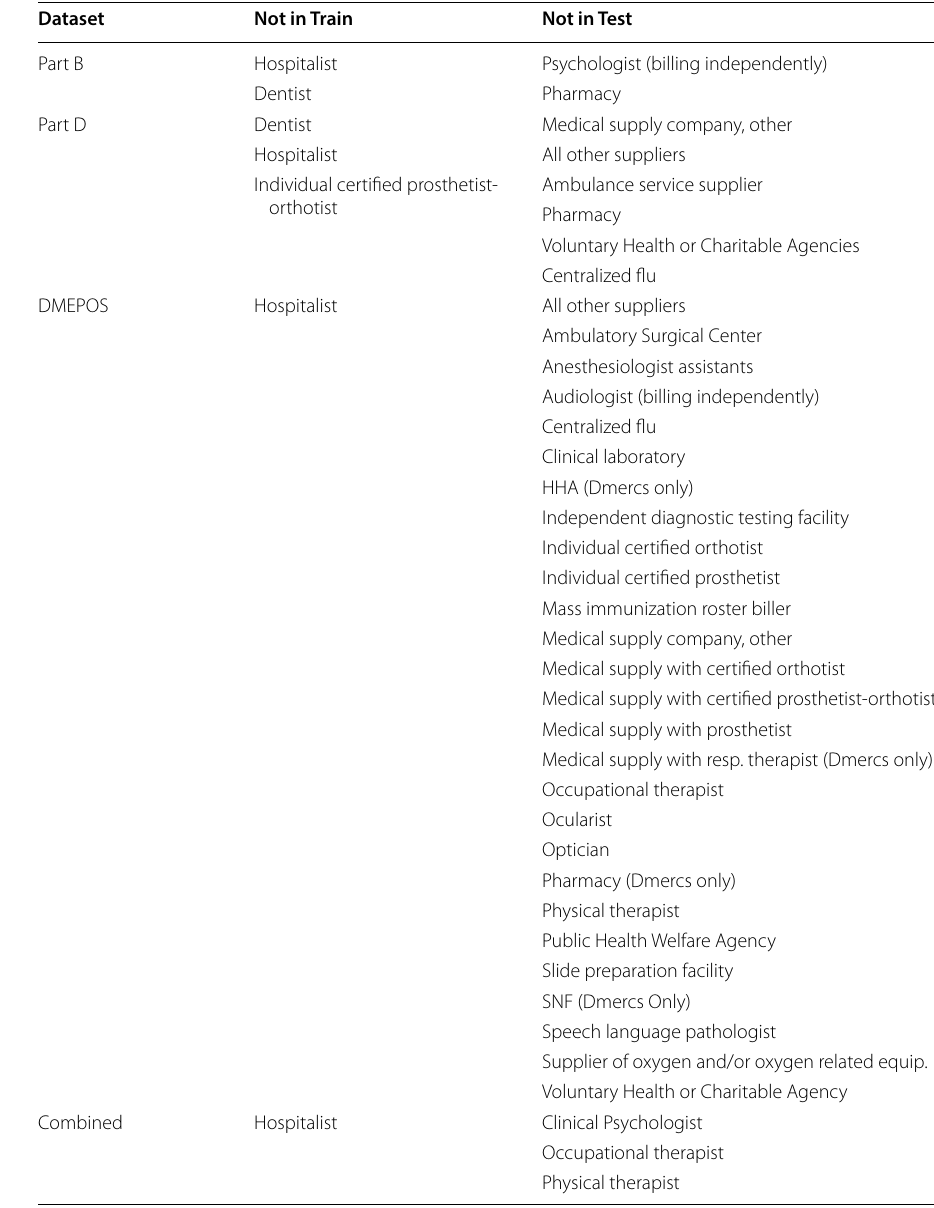
Table 7 Provider type labels removed from train and test datasets